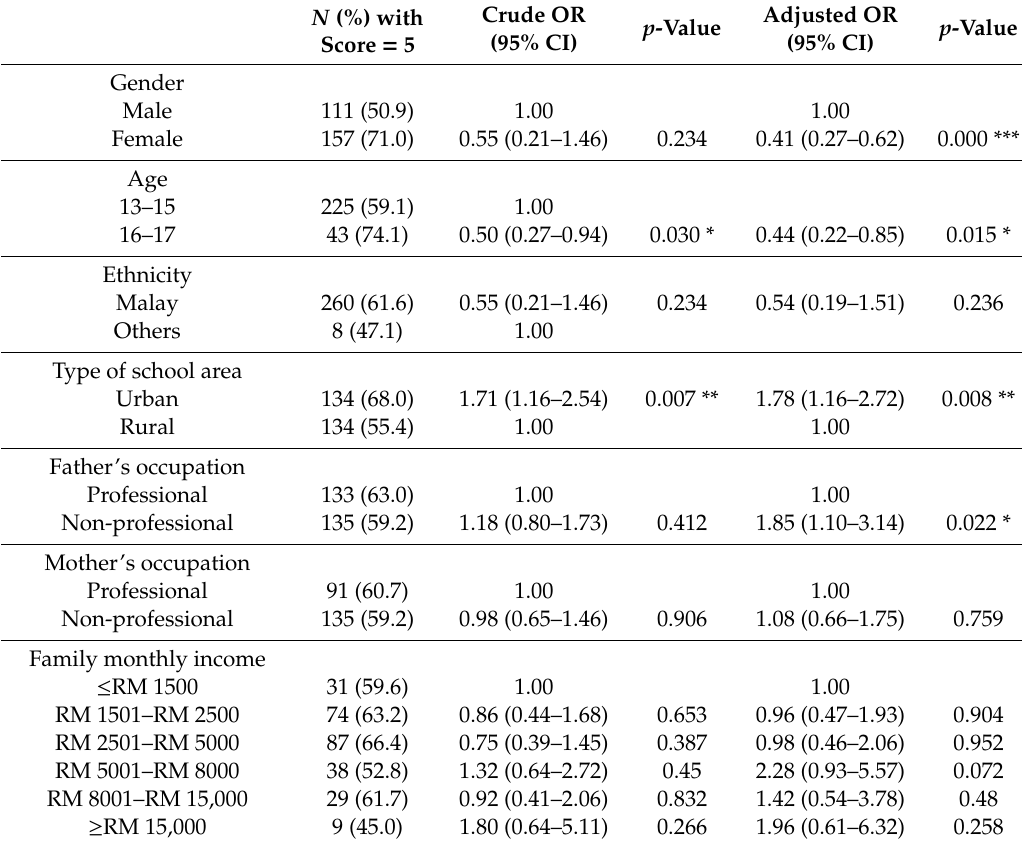
Table 5. Bivariable and multivariable logistic regression predicting attitude on SSB among participants, ( N = 439).